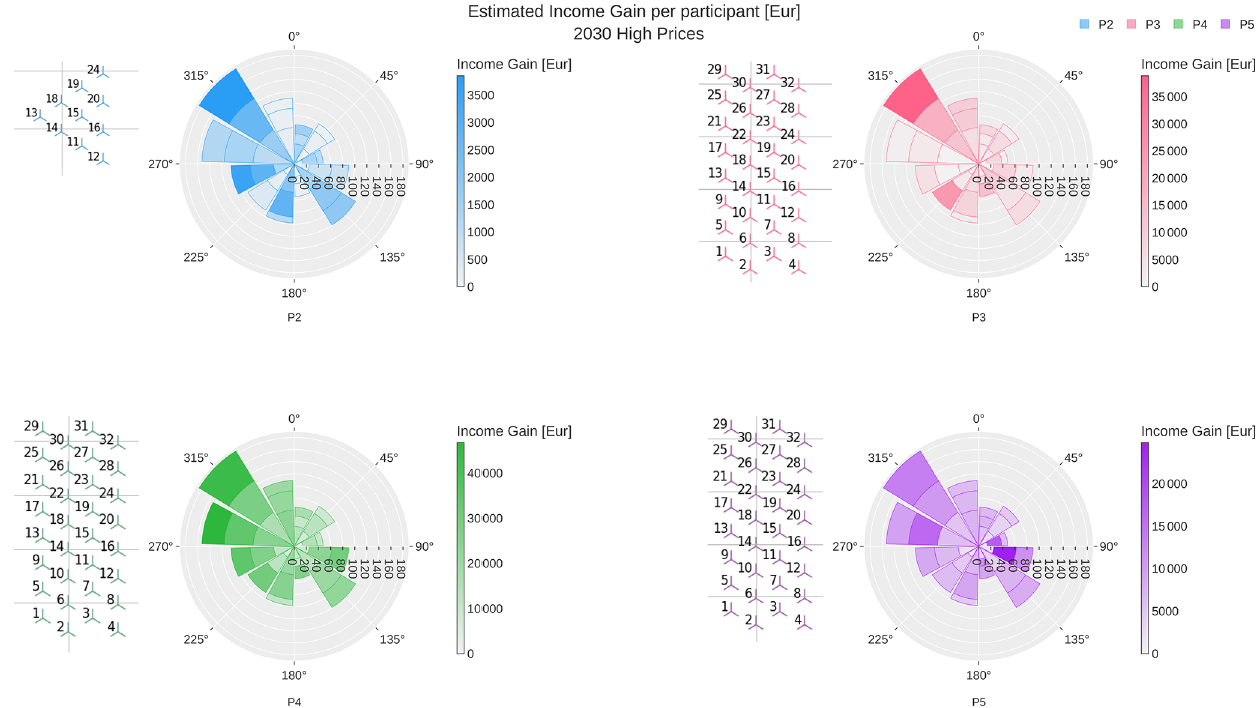
Figure 11. Income gain when using wind farm flow control (WFFC) in simulations with the wind inflow and price information for 2030 as shown in Fig. 1. Each polar plot presents the results of one participant. The wind farm layout considered by this participant is shown on the left side of the polar plot. The estimated income with WFFC is compared to the income under normal operation without WFFC. For each sector, the stacked gains are indicated as heat maps and reported per 7, 9 and 11ms − 1 along the radial direction, with respect to the number of samples per bin.